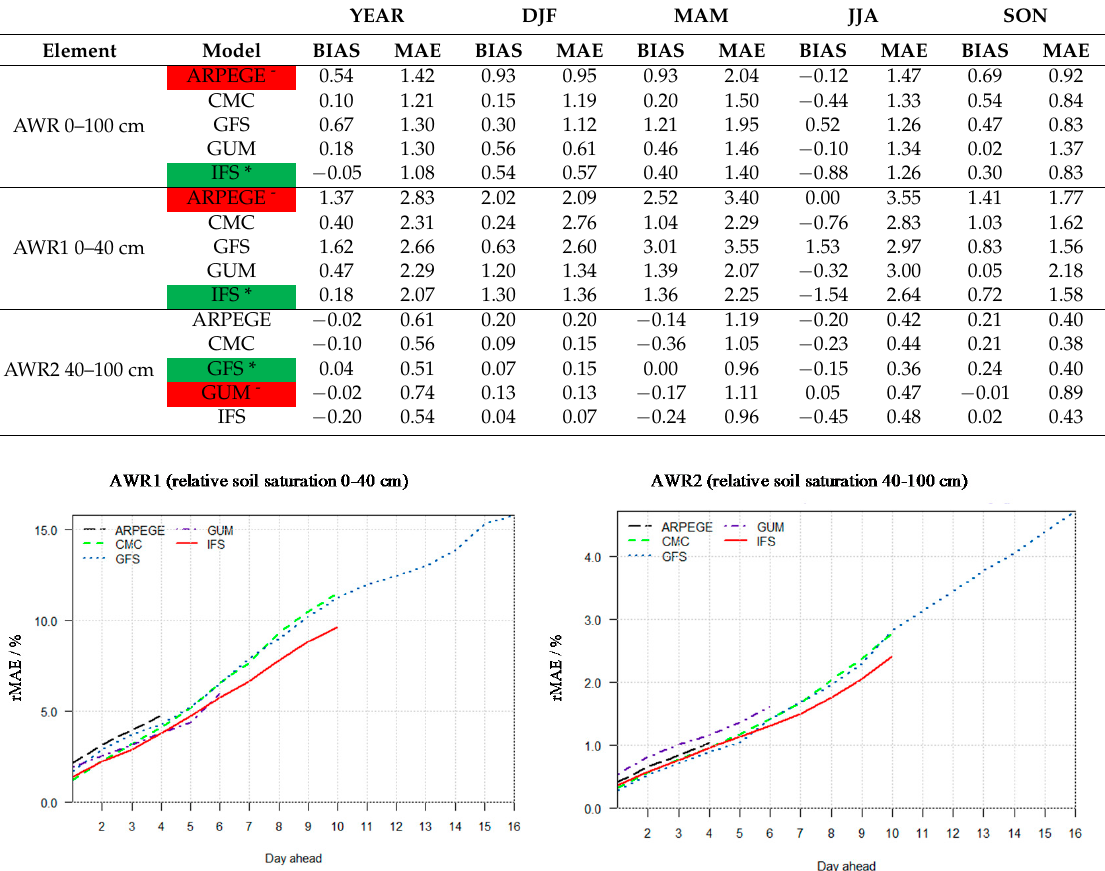
Figure 6. Relative MAE (mean absolute error), as difference of forecast and AWR (relative soil saturation) in two depths: ( left ) upper (0–40 cm) soil profile, and ( right ) deeper (40–100 cm) soil profile.